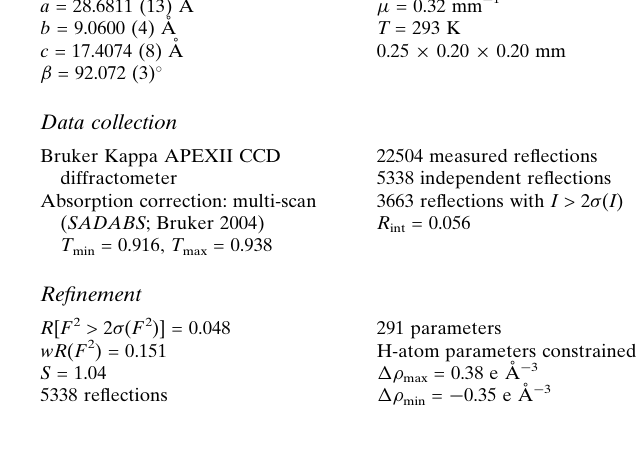
Bruker Kappa APEXII CCD diffractometer Absorption correction: multi-scan ( SADABS ; Bruker 2004)